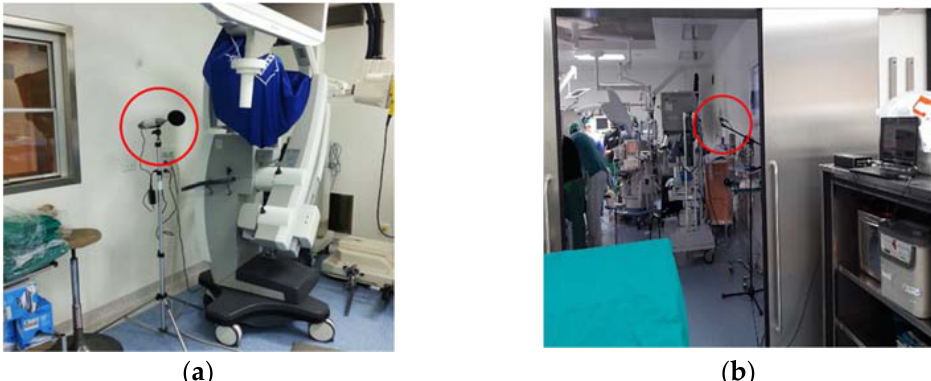
Figure 1. Example of the microphone’s location, highlighted by the red circle, selected for the noise measurement in the surgical room: ( a ) survey 1, ( b ) survey 2.